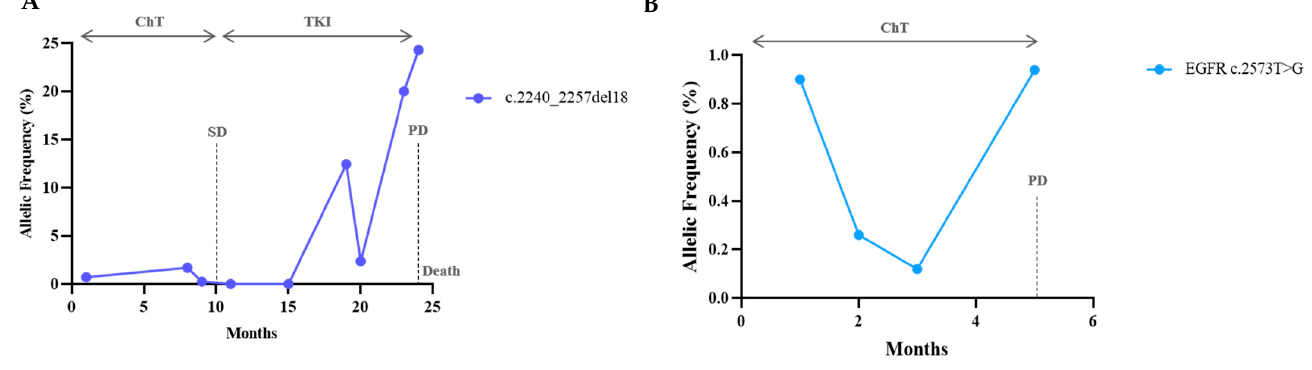
Figure 4. Progression with an increase in the sensitising mutation. ( A , B ) Serial ctDNA measurements revealed a VAF decrease with treatment and before radiological progression. There was an increase in the original mutation without other detectable alterations. In ( A ), tissue re-biopsy at 24 months was negative for T790M.